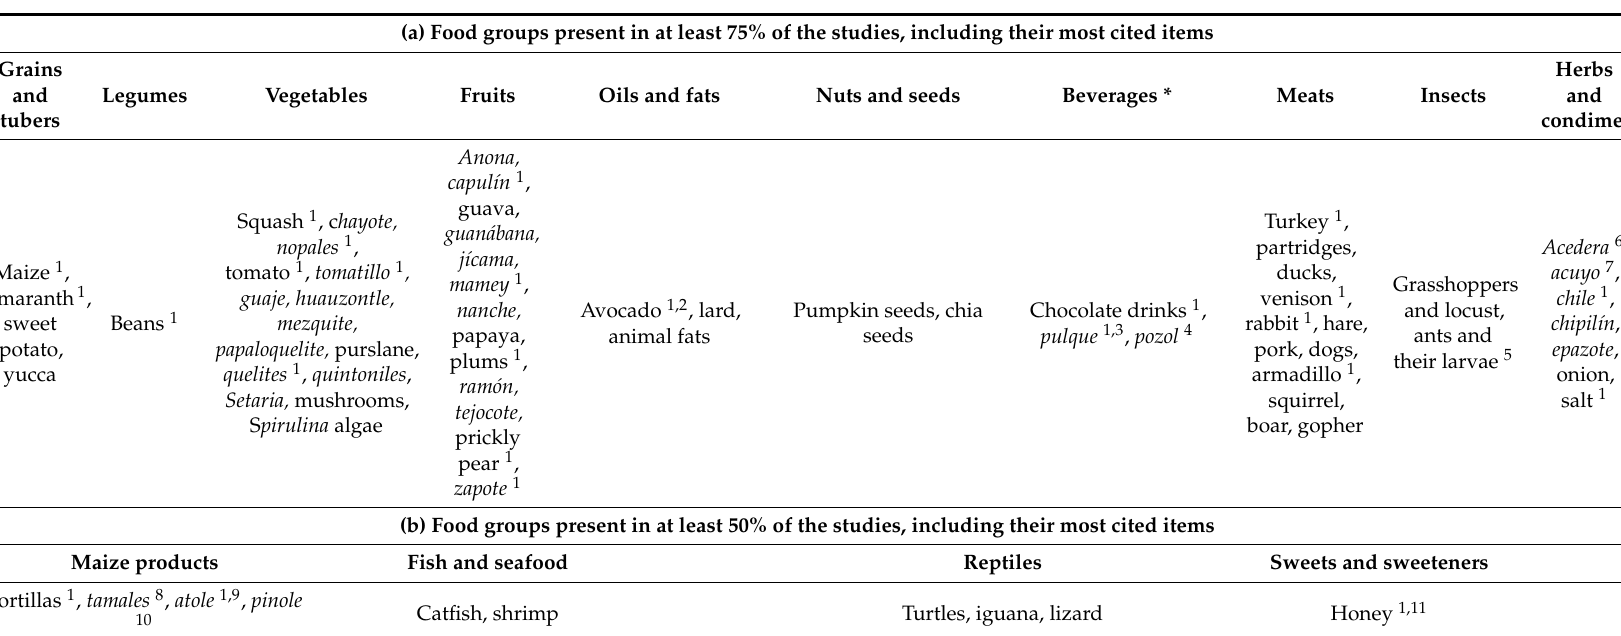
Table 7. Most cited items and food groups present in studies referring to Southern Mexico ( n =